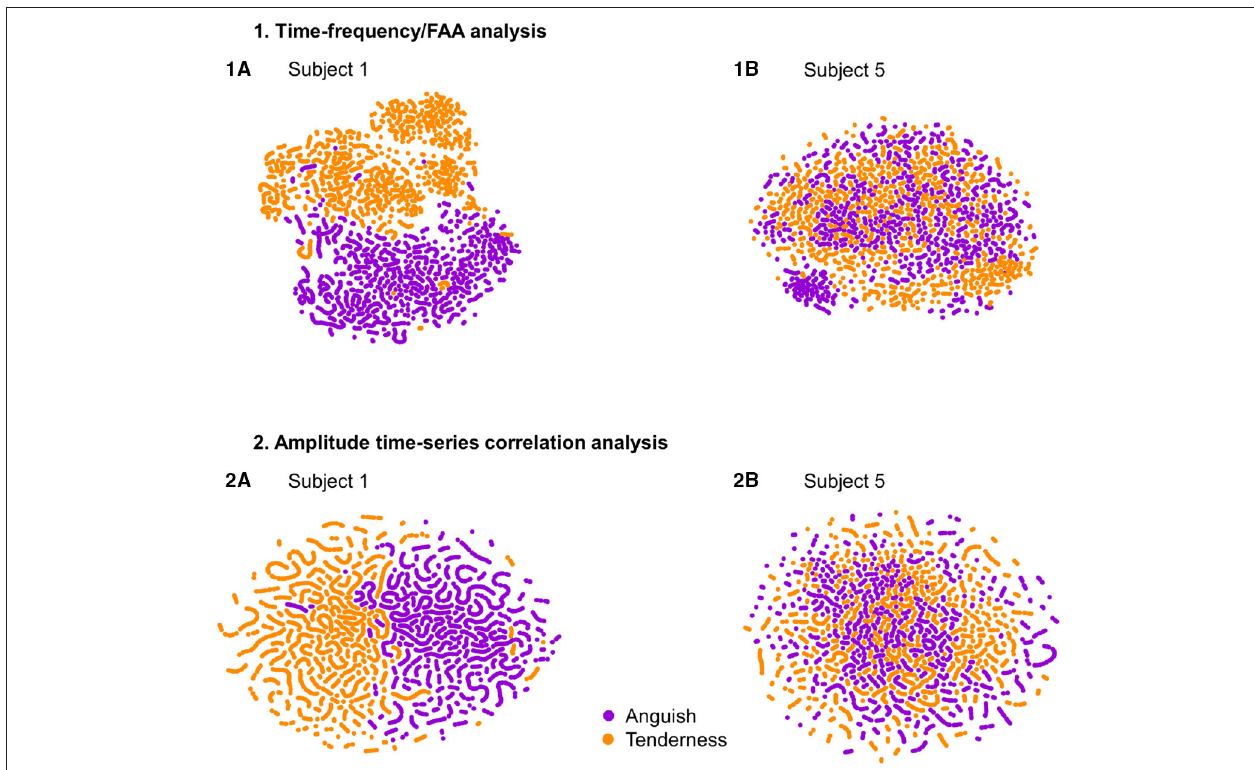
FIGURE 4 | T-SNE visualization for the feature sets of subjects 1 and 5, with the best performance (1A,2A) and one of the worst classification performances (1B,2B) , respectively. Samples of the classes “Anguish” and “Tenderness” are plotted in violet and orange, respectively. The upper two plots (1A,1B) depict the time-frequency analysis datasets. The two plots at the bottom (2A,2B) display the two participants’ amplitude time-series correlation